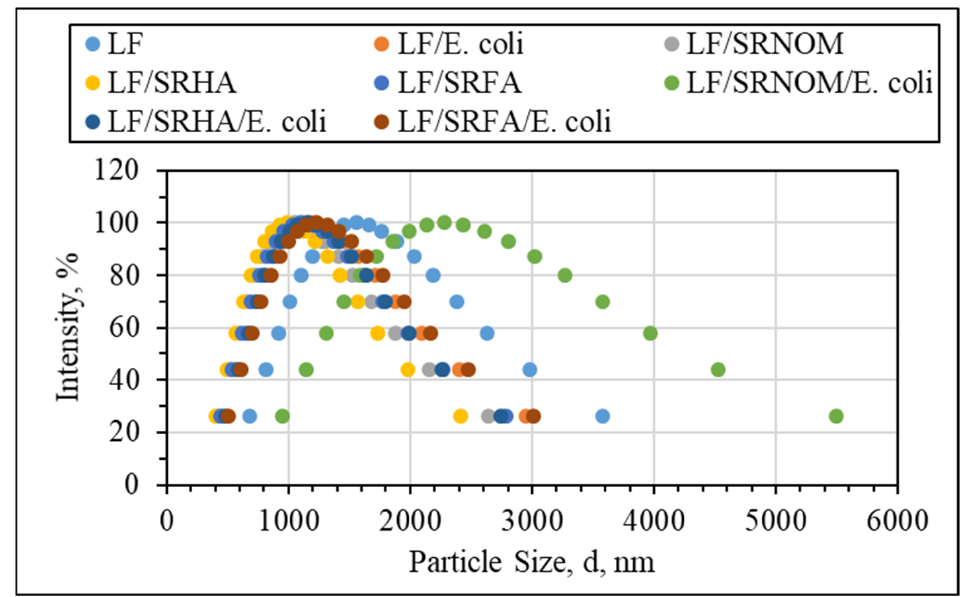
Figure 2. Hydrodynamic particle size distribution profiles of LF for binary and ternary systems.